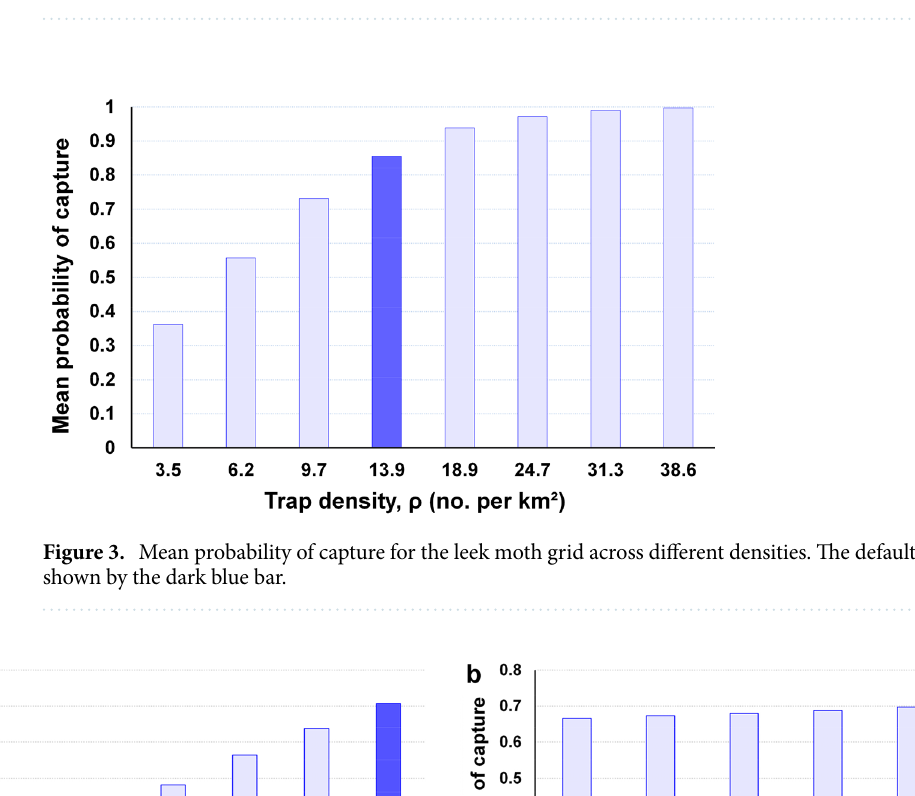
Table 1. The probability of capture for the standard Medfly grid, for different bands, and for the grid with a uniform density of 38.6 trap per km 2 . *mean ± 95 percent confidence limits.